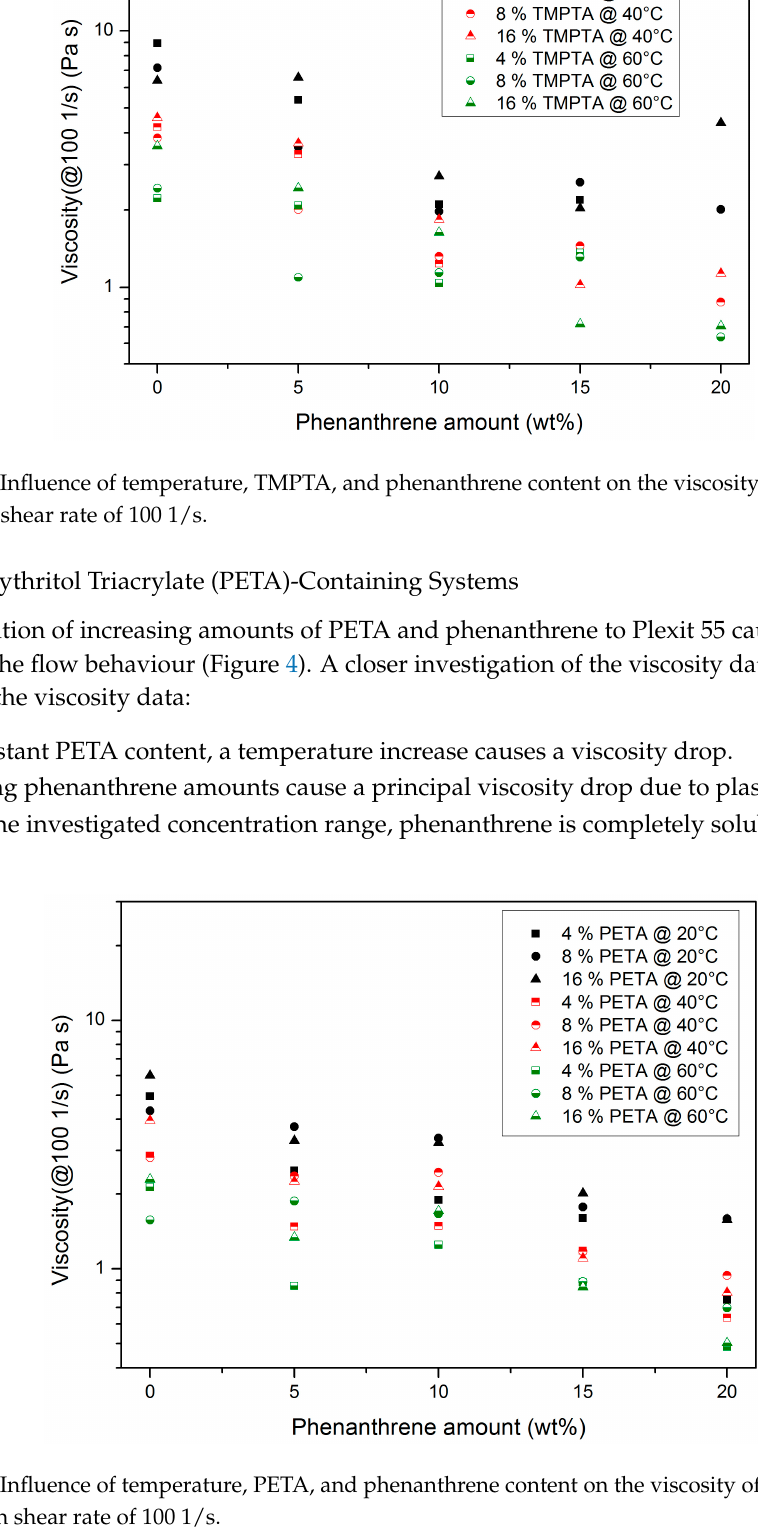
5 of 13 Figure 2. Shear rate and temperature-dependent viscosity of all investigated pure components. 3.1.1. Trimethylolpropantriacrylate (TMPTA)-Containing Systems The addition of increasing amounts of TMPTA turned the pseudoplastic flow into a Newtonian flow, as expected from Figure 2. Figure 3 summarizes the influence of temperature and chemical com- position on the resulting mixture viscosity for a selected shear rate of 100 1/s. The main results are: •